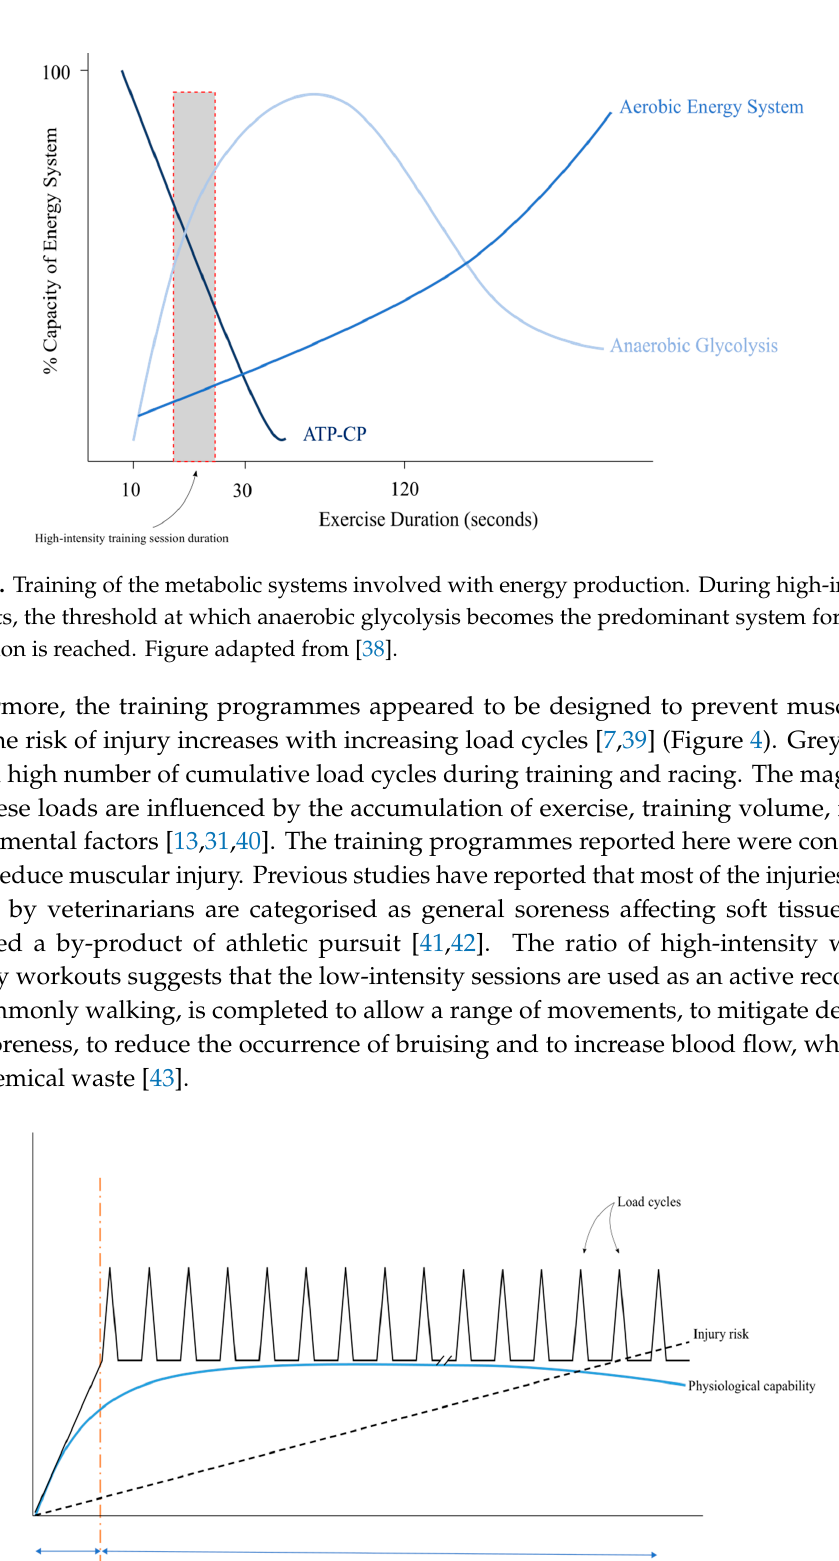
Figure 4. Loading and performance stages of greyhound training and racing. Young dogs are